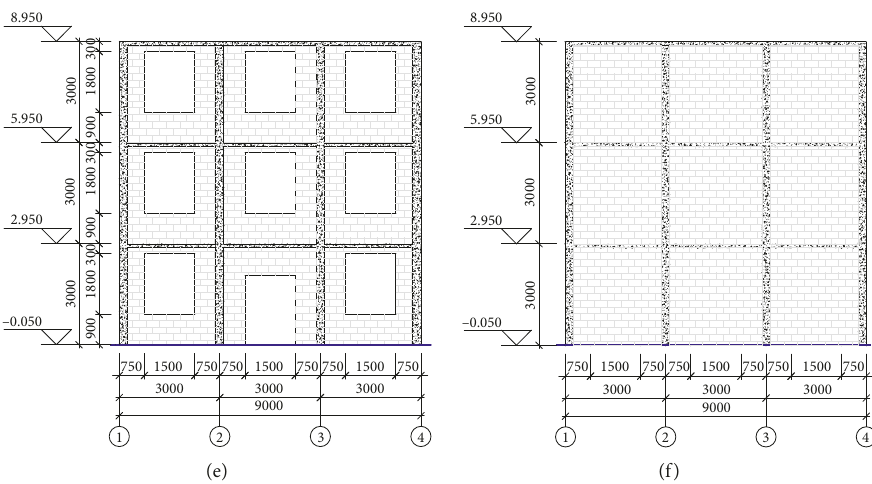
Figure 2: Layout of the three-layer masonry example structure (unit: m, mm). (a) Plane layout. (b) Ring beam layout. (c) Façade of ① / ④ axes. (d) Façade of ② / ③ axes. (e) Façade of Ⓐ axis. (f) Façade of Ⓒ